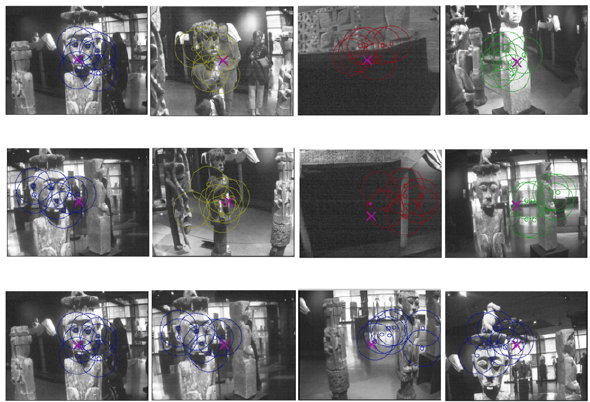
Figure 7: Learning mode, (Top) and (Middle) represent the objects learning from different distances and angles. (Bottom) represents the object 1 learning from different angles and distances. The cir- cles represent the object’s identity.